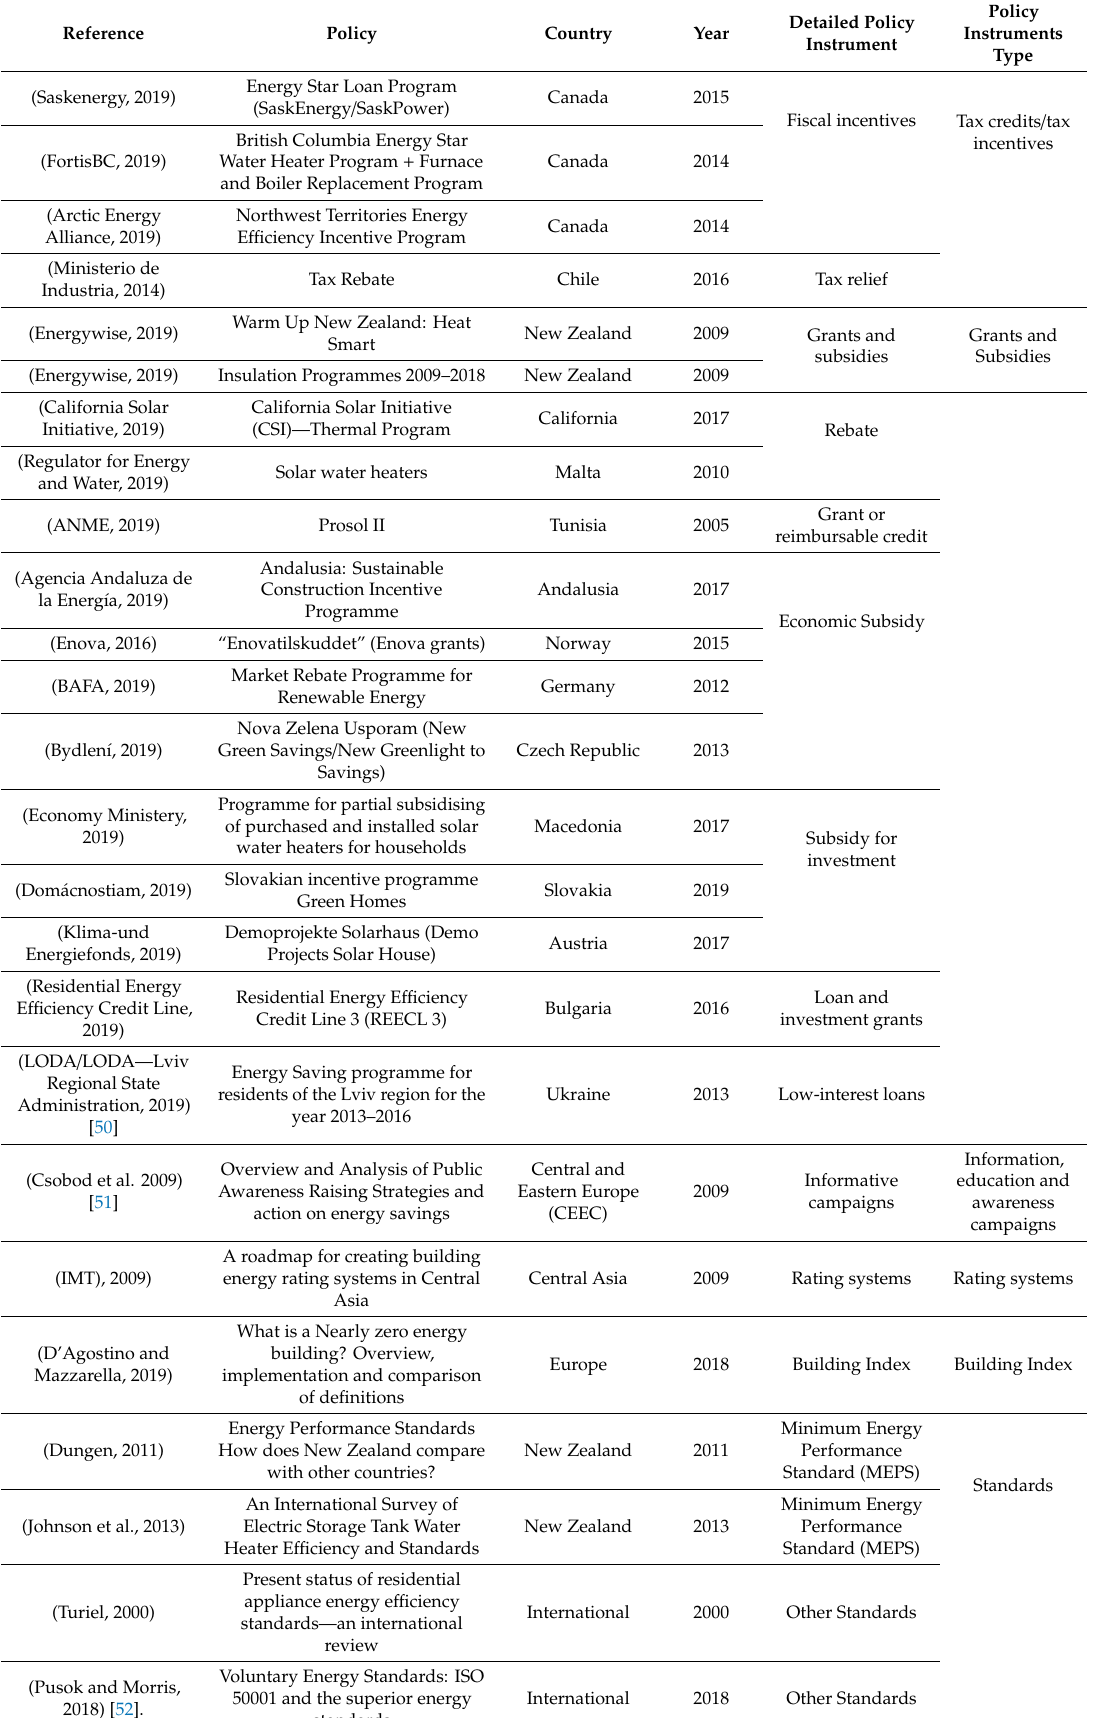
Table 4. Policy Instruments